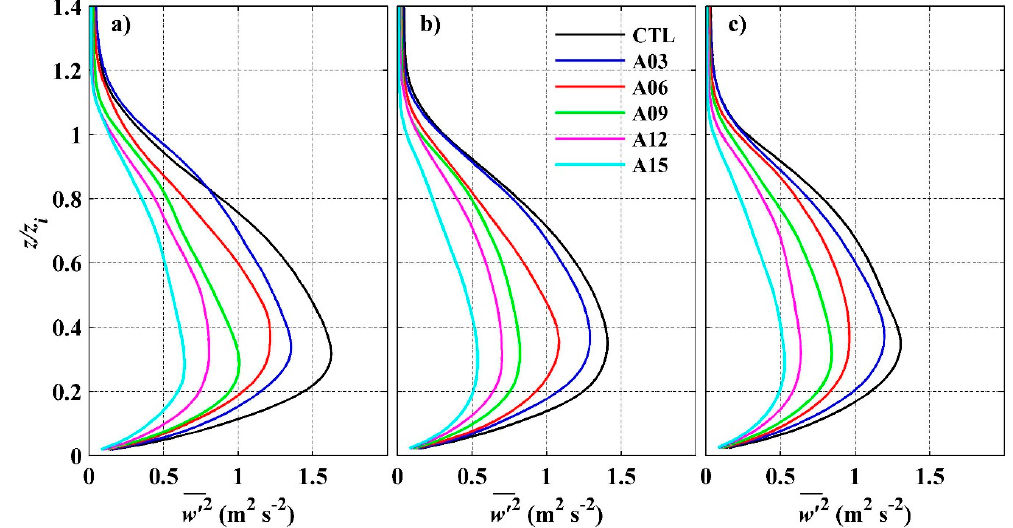
Figure 10. Profiles of vertical velocity variance ( w (cid:48) 2 ) for the cases with three different stratification strengths in the free atmosphere: ( a ) 3 K km − 1 , ( b ) 6 K km − 1 , and ( c ) 9 K km − 1 . The color scheme for cases with different AOD is the same as in Figure 8.